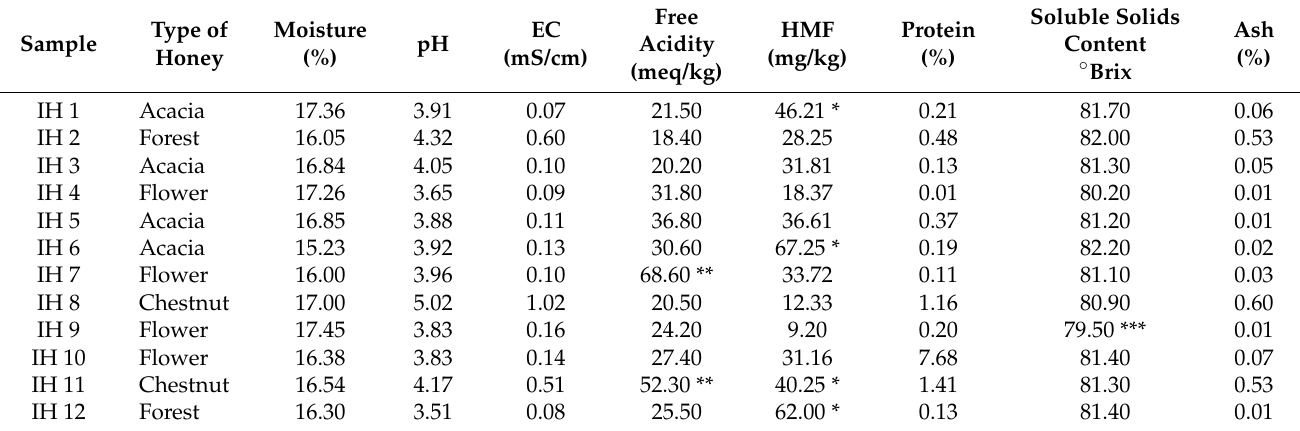
Table 3. Physicochemical parameters of imported honey samples (IH).